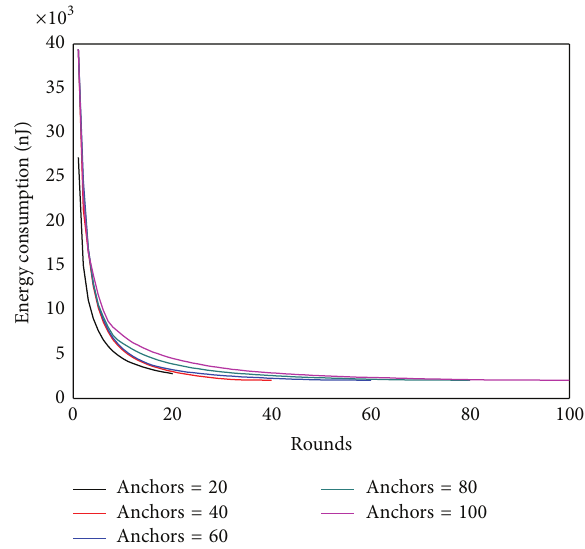
Figure 27: Energy per round under different numbers of anchor (experimental value).